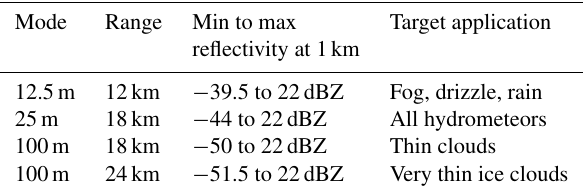
Table 2. BASTA range resolution modes and their applications.